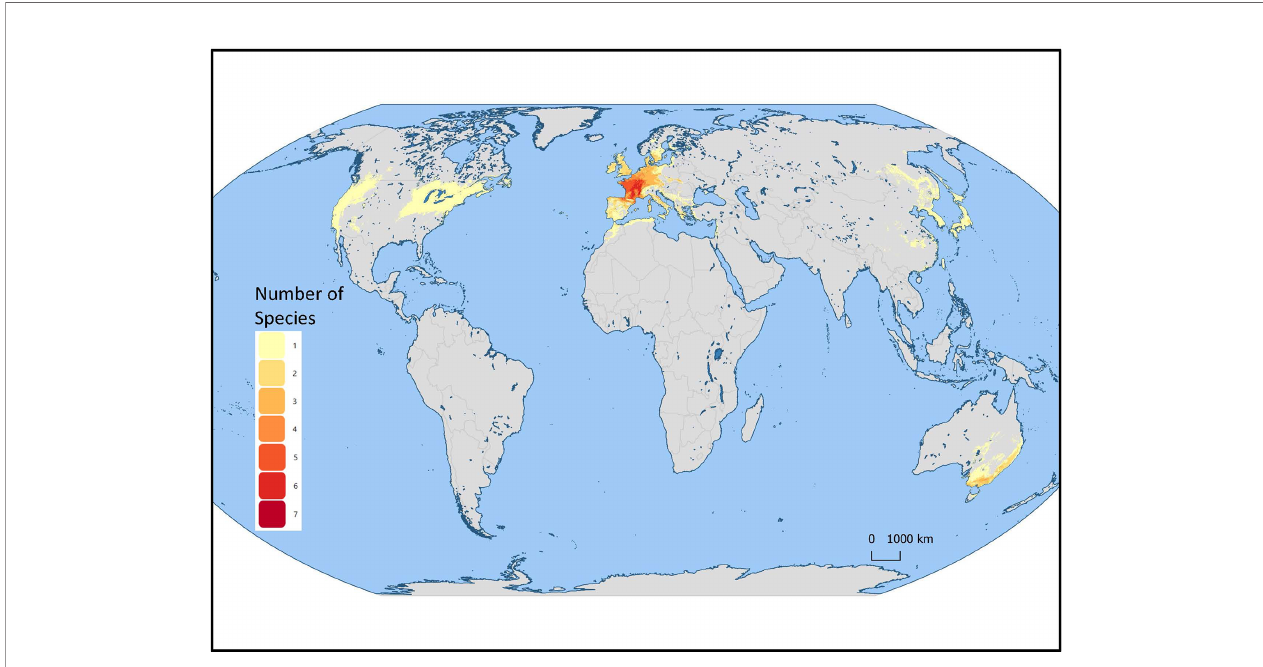
FIGURE 3 | Mentha L. European region of the global richness map for 17 endemic European Mentha species. The colors indicate the number of species in that